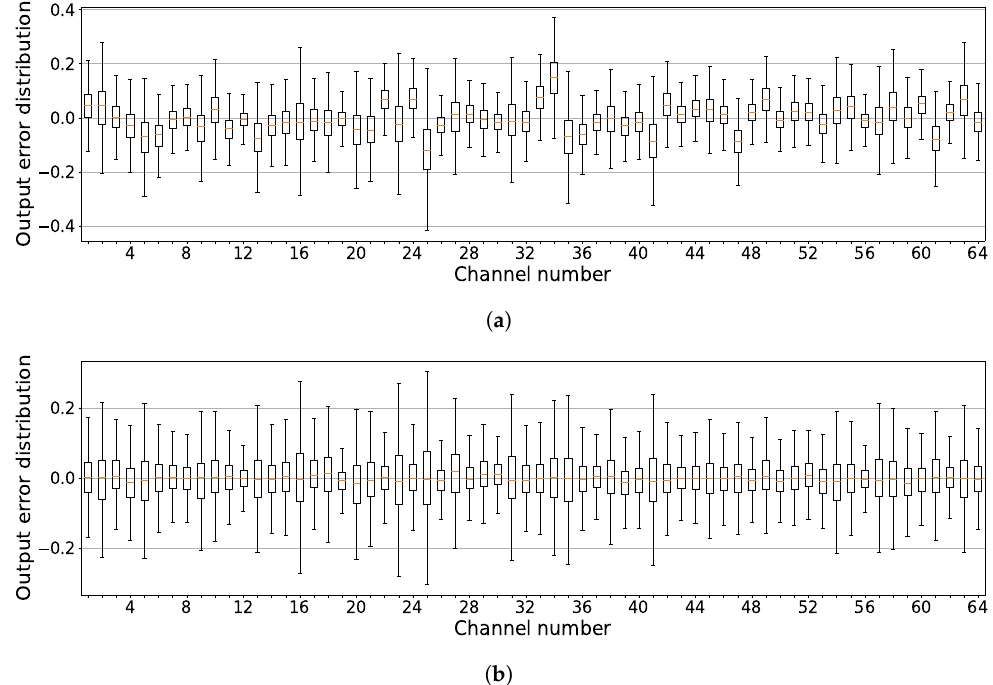
Figure 5. Channel-wise boxplots of the differences between the layer1.1.bn1 layer outputs of ResNet-18 on the ILSVRC-2012 dataset with the original and decomposed layer1.1.conv1 layers. ( a ) Without the calibration of the BN statistics, the error distribution in each channel has a different mean and variance, which might negatively affect the network performance. ( b ) Calibration of the BN statistics allows the alignment of channel-wise error distributions and makes them zero-mean, which partially recovers model performance after